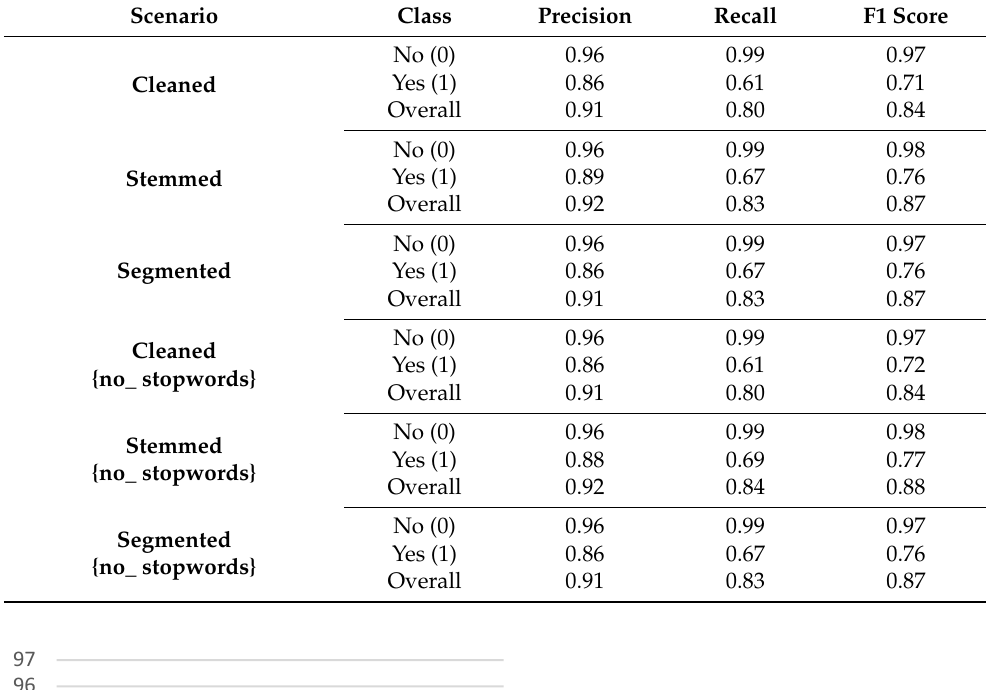
Table 4. Performance of extracted scenarios.